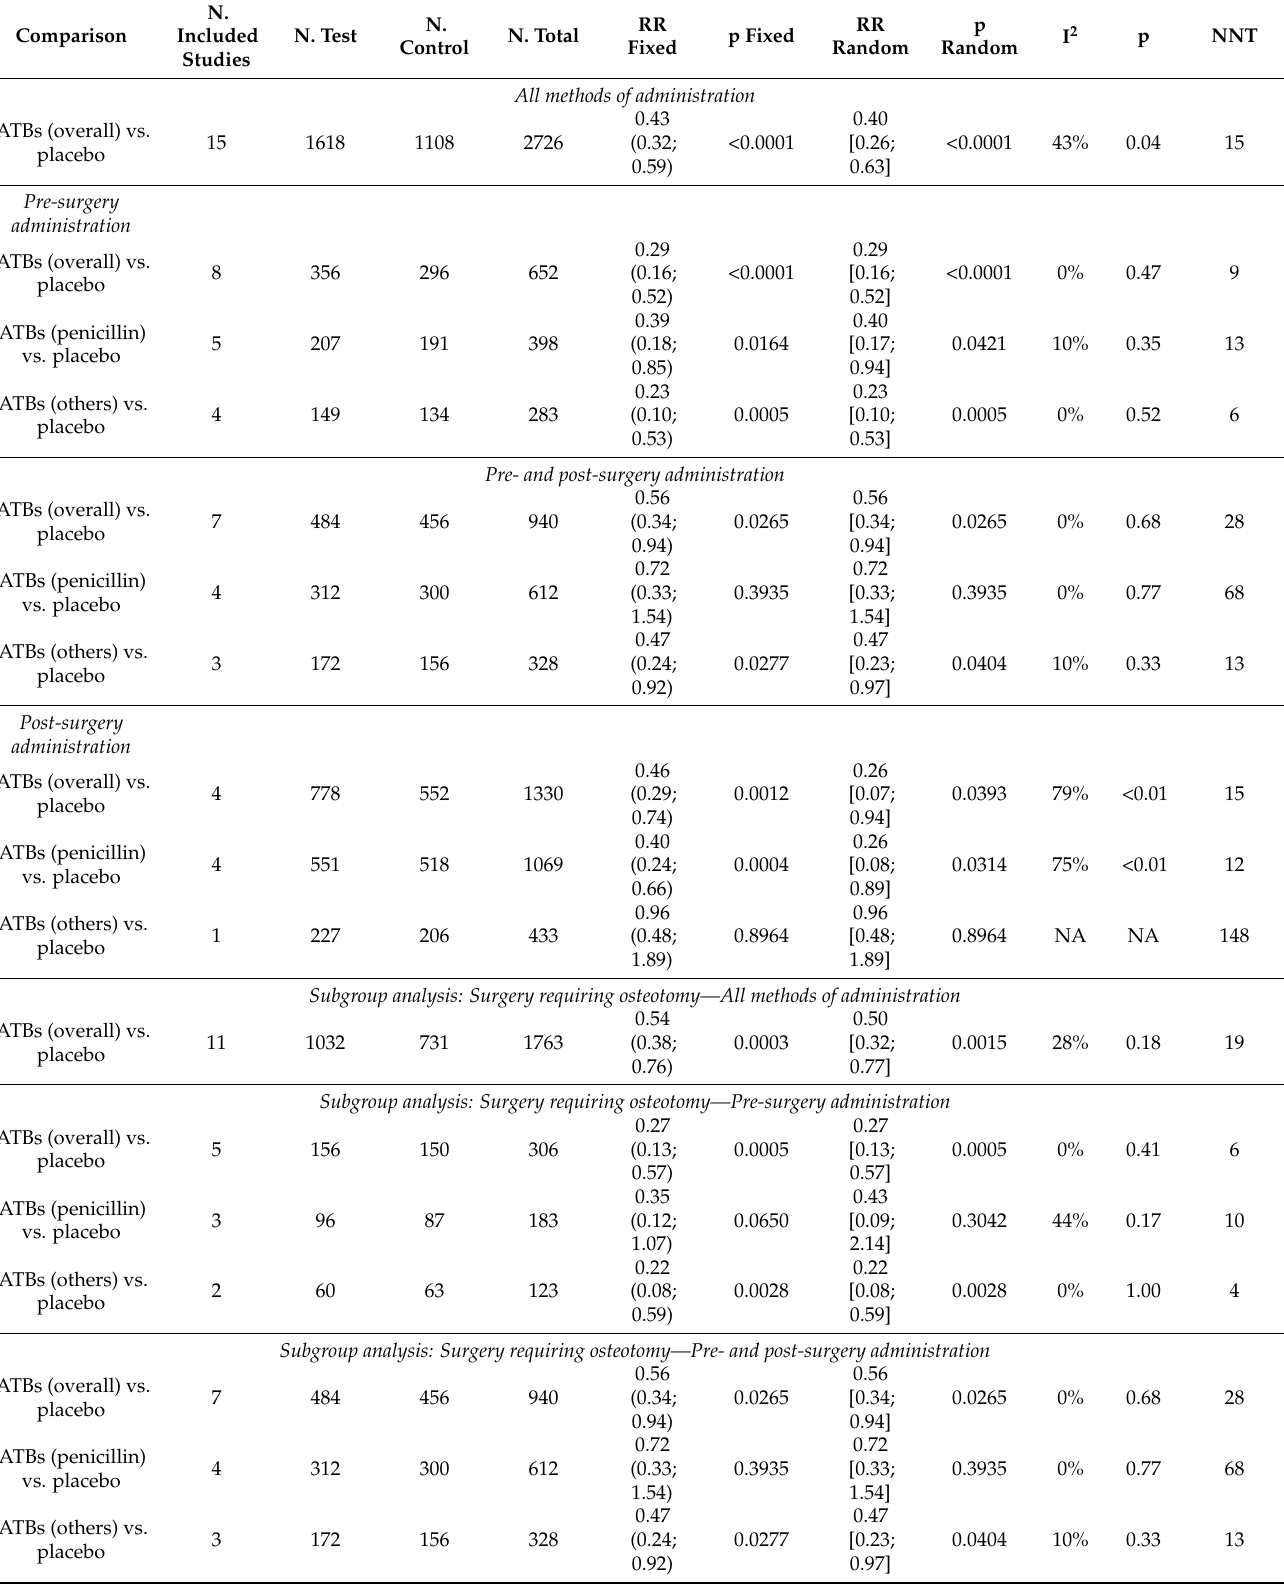
Table 4. Summary of meta-analysis